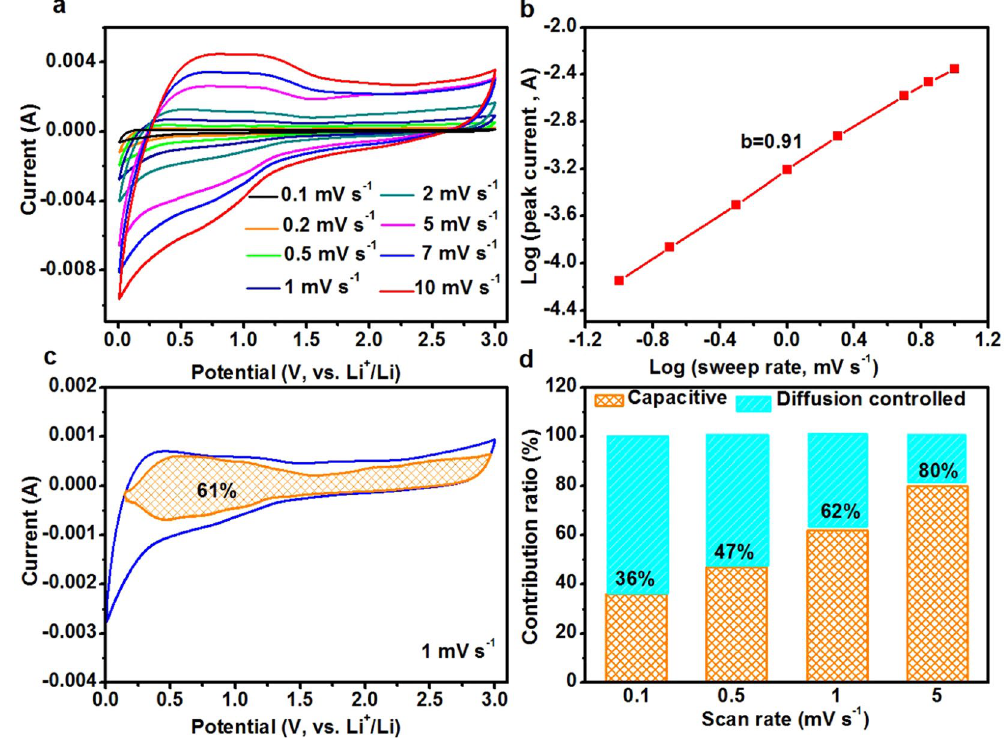
Figure 5. ( a ) CV curves of the BPC electrode at various scan rates from 0.1 to 10 mV s − 1 . ( b ) Determination of the b value using the relationship between peak current and scan rate. The redox peak at 0.7 V was used for the calculations. ( c ) Separation of the capacitive and diffusion currents at a scan rate of 1 mV s − 1 . ( d ) Contribution ratio of the capacitive and diffusion-controlled charge versus scan